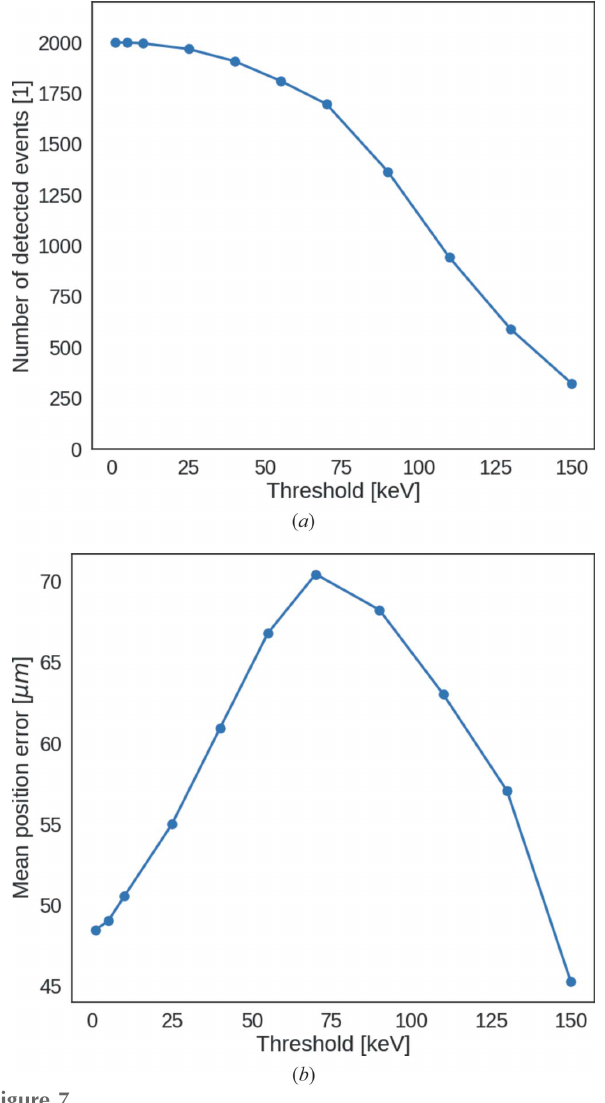
Figure 7 ( a ) Simulation of the number of detected events as a function of threshold for 200 keV electrons. ( b ) Simulation of the mean position error as a function of threshold for 200 keV